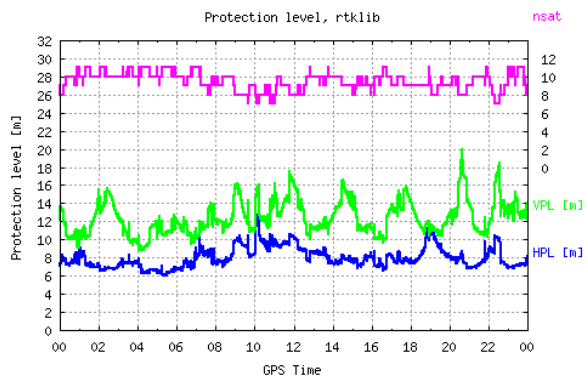
Figure 1. Protection levels calculated by RTKLIB.